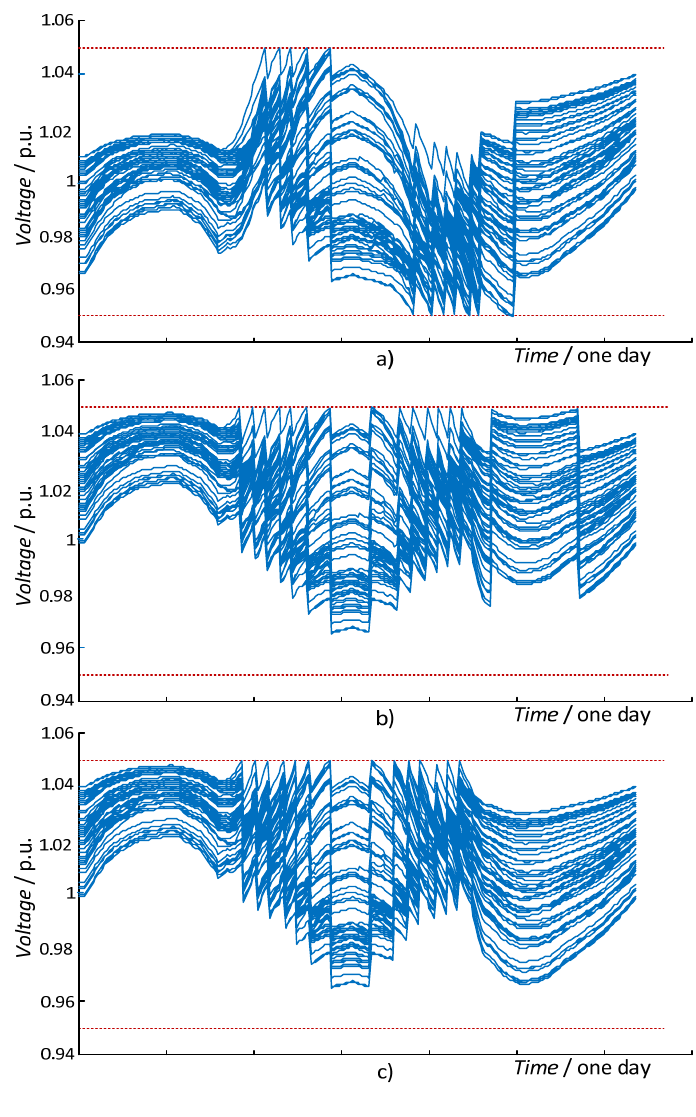
Figure 13. One-day voltage profile of MV/LV substations measured at the critical areas around the distribution system using a time-dependent tg φ . ( a ) Voltage profile for tg φ set-point with minimal losses; ( b ) voltage profile of the whole algorithm for tg φ with minimal losses and optimal OLTC set-point; ( c ) during the evening the tap-changer did not change its position and thus operations were reduced for